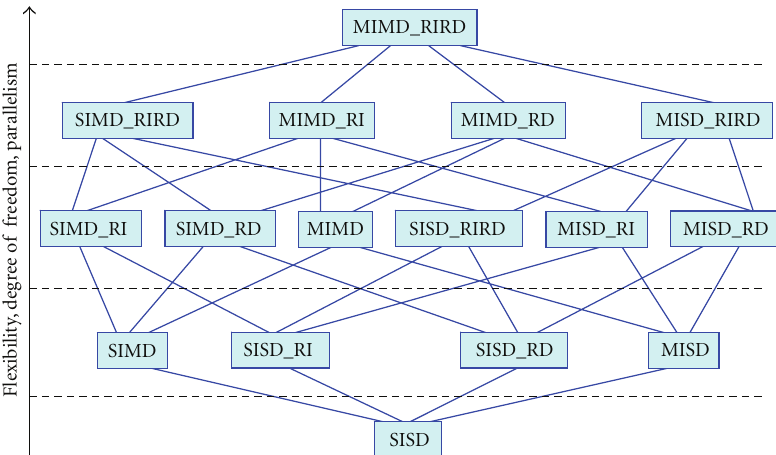
Figure 3: Hierarchy of the classes depending on their degree of freedom, their flexibility, and parallelism. The neighborhood relations are shown by the connections between the